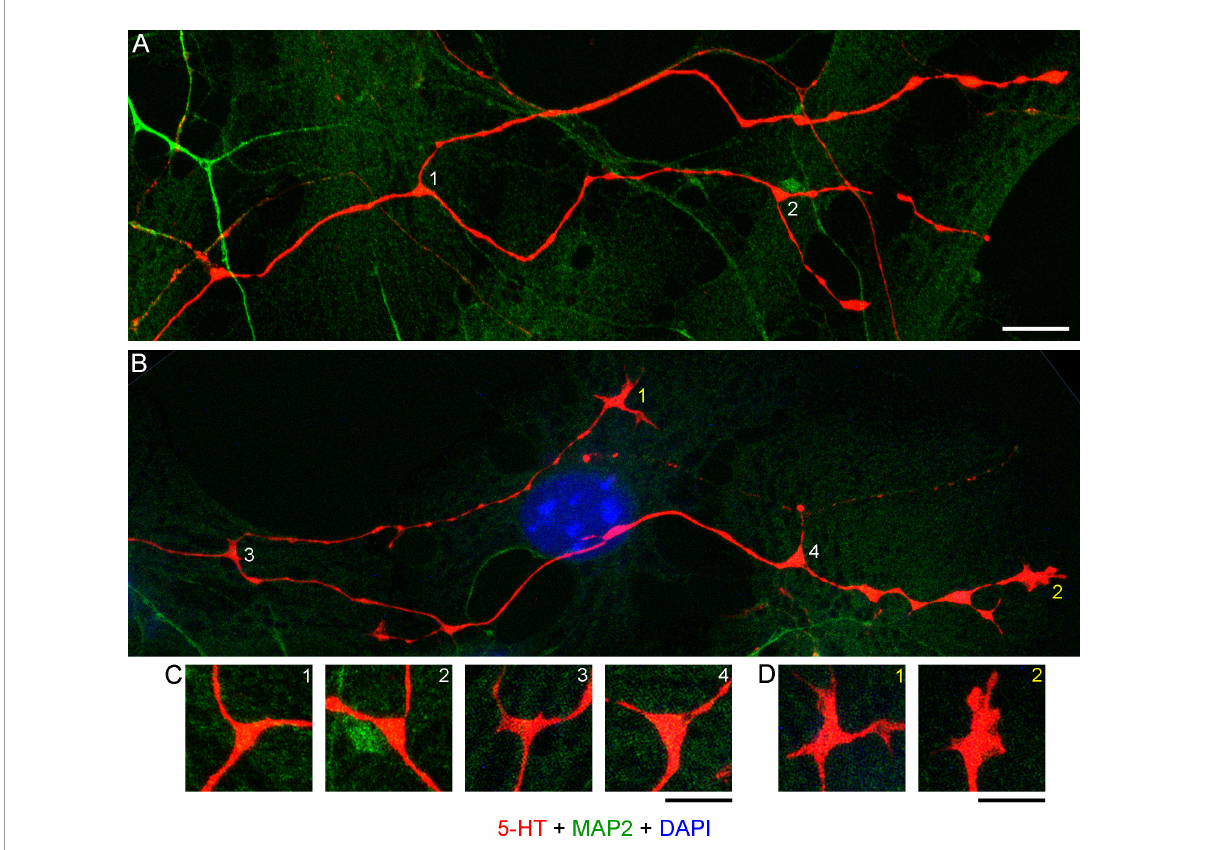
FIGURE11 (A) Primary midbrain culture (monolayer at DIV 4), visualized with immunocytochemistry for 5-HT (red) and MAP2 (green) and imaged with high-resolution confocal microscopy. Cell nuclei are stained blue (DAPI). (A,B) Four branching regions (white 1–4) and two growth cones (yellow 1–2) and are shown. Note that the two branches in (B) differ in their morphologies. (C) An enlarged view of the branching points. The branching regions have a triangular shape, and the branches diverge at large angles (around 90 ◦ –180 ◦ ). (D) An enlarged view of the growth cones. Note the similarity of the second growth cone to that in the embryonic mouse brain ( Figure 9 ). Scale bars = 10 µ m in (A,B) , 5 µ m in (C,D)